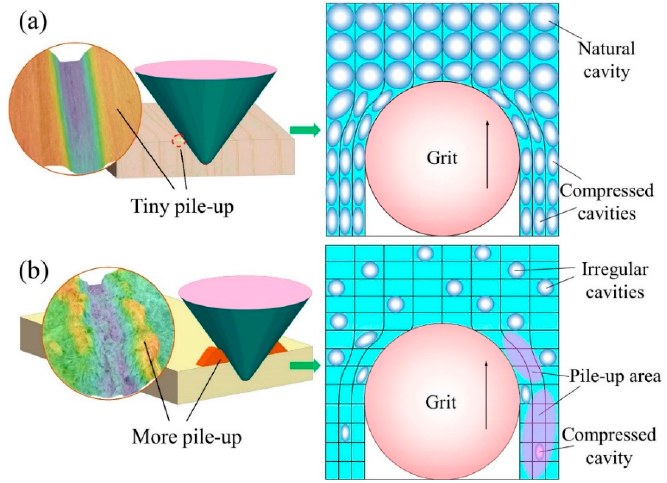
Figure 6. Schematic of the anatomical cavities absorbing effect ( a ) when scratching Korean Pine ( λ = 0°) and ( b ) when scratching MDF.